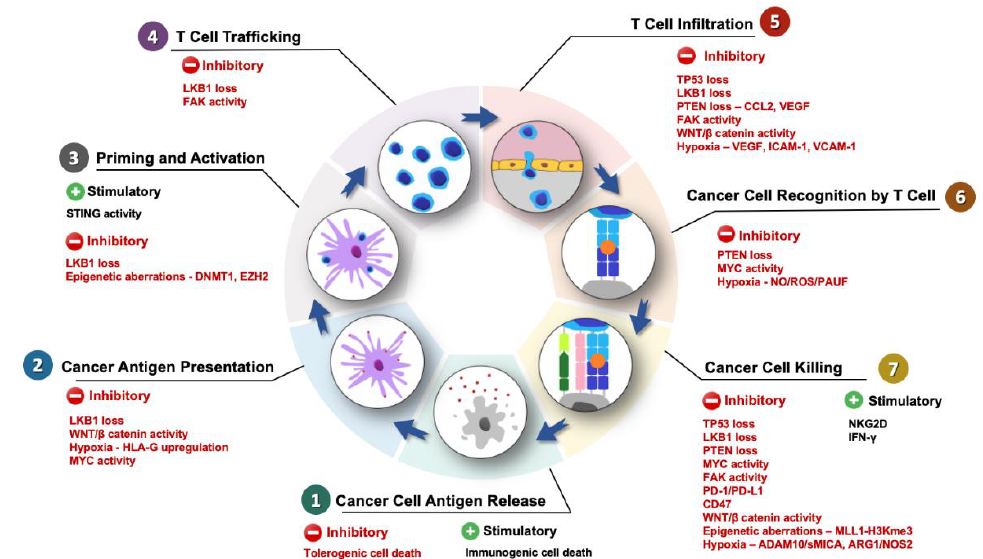
Figure 1. Stimulatory and inhibitory factors that may affect the cancer immunity cycle in pancreatic ductal adenocarcinoma (PDAC). The anti-tumor immune response cycle starts with cancer cell antigen release (Step 1), whereupon the apoptosis of cancer cells (gray cells) takes place and cancer cell antigens (red small dots) are released and subsequently picked up by dendritic cells (purple cells). Antigen-presenting cells, mainly dendritic cells, can then process the cancer-specific antigens and present them to T helper cells (Step 2), allowing for the priming and activation (Step 3) of the immune cells (blue circular cells). Once activated, the immune cells traffic to the tumor site (Step 4) and infiltrate the tumor (Step 5). Within the tumor microenvironment (TME), cancer cell recognition (Step 6) by the T cell eventually leads to cancer cell killing (Step 7). LKB1, liver kinase B1; MYC, oncogenic myelocytoma; HLA, human leukocyte antigen; STING, stimulator of interferon genes; DNMT, DNA methyltransferase 1, EZH2, enhancer of zeste homolog 2; FAK, focal adhesion kinase; PTEN, phosphatase and tensin homolog; NO, nitric oxide; ROS, reactive oxygen species; PAUF, pancreatic adenocarcinoma upregulated factor; NK2D, natural killer group 2D receptor; IFN, interferon; PD-1, programmed cell death protein 1; PD-L1, programmed death-ligand 1; CD47, cluster of differentiation 47; H3K4me, H3K4 trimethylation; ADAM10, A Disintegrin and Metalloproteinase Domain 10; sMICA, soluble MHC class I-related molecule A; HIF1A, hypoxia-inducible factor 1-alpha; CCL2, Chemokine ligand 2; COX2, cyclooxygenase 2; PGE2, prostaglandin E2; VEGF, vascular endothelial growth-factor; ARG1, arginase 1; NOS2, nitric oxide synthase 2.